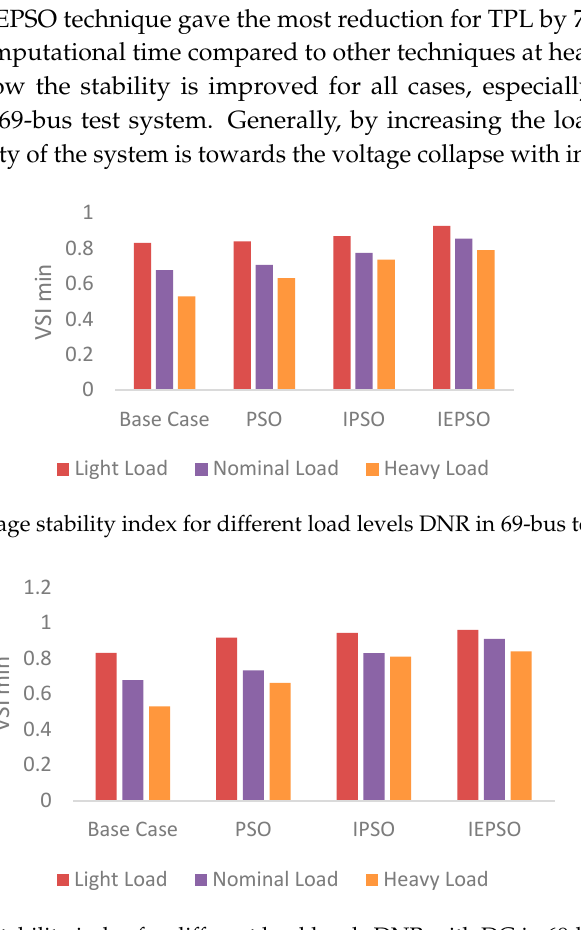
Figure 9. Voltage stability index for different load levels DNR with DG in 69-bus test system.